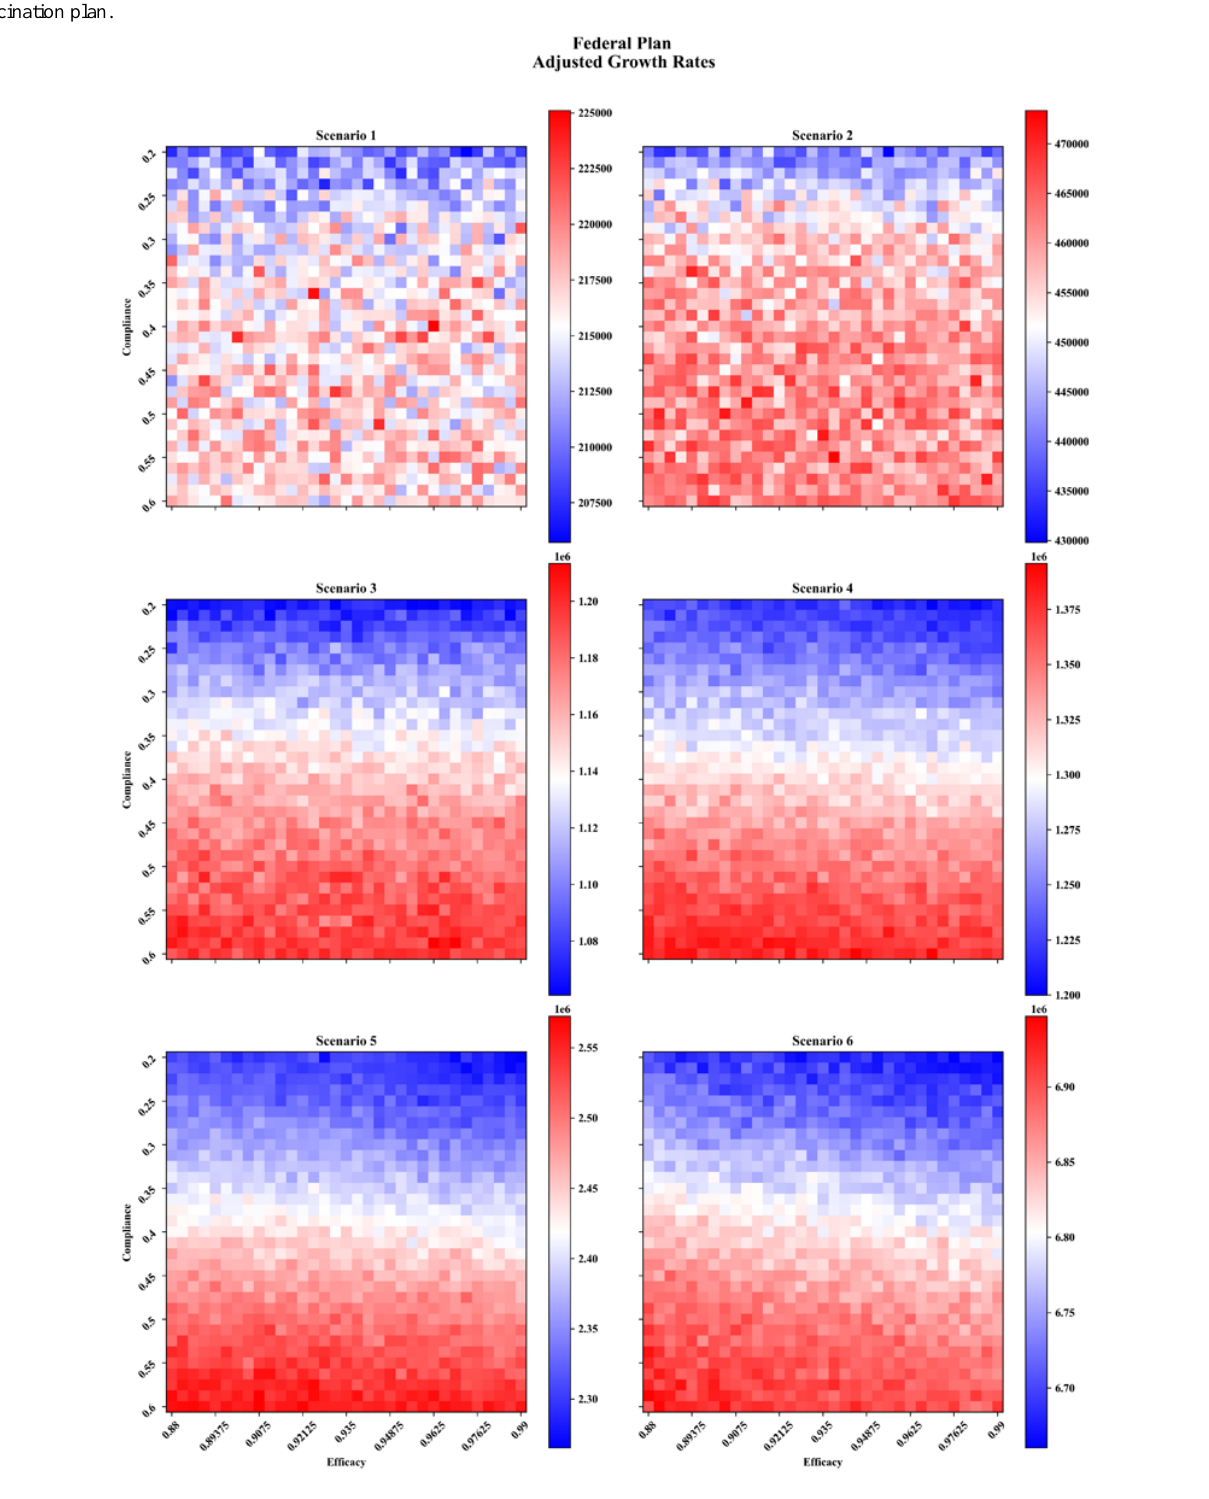
Figure 8. Adjusted growth rate (number of infected individuals on the worst day) as functions of vaccine compliance and efficacy under the Trump vaccination